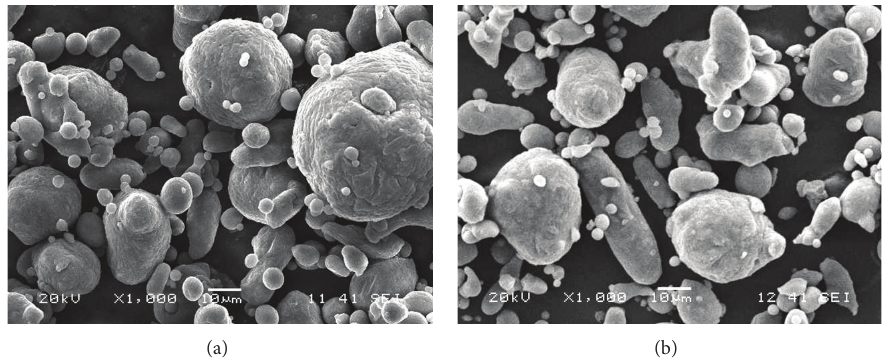
Figure 1: SEM micrographs of powders: (a) Al6061 and (b) Al2124.